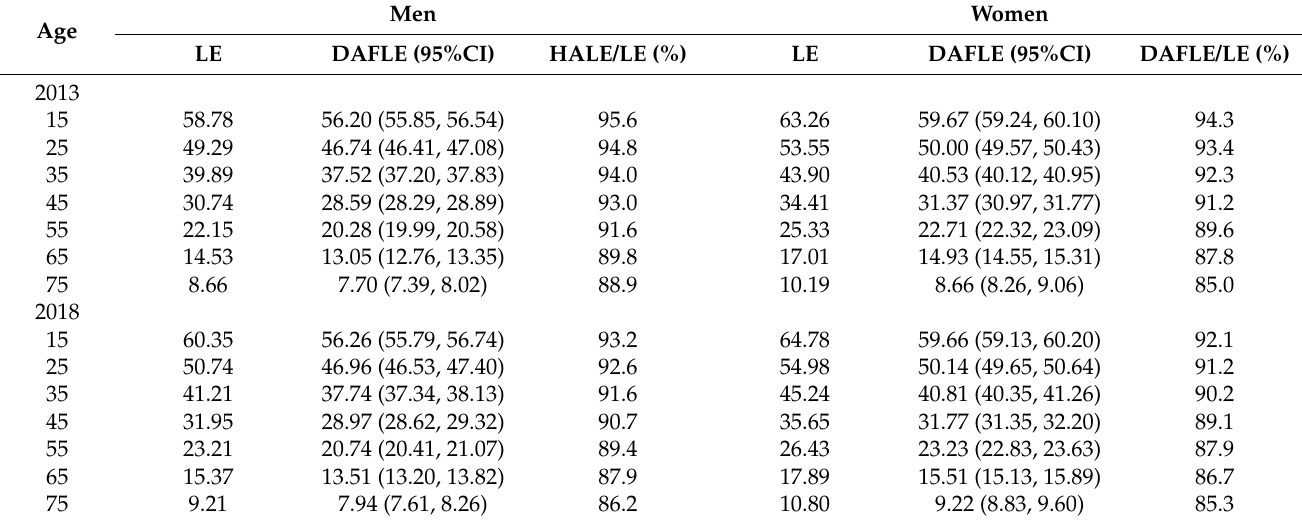
Table 1. LE, DAFLE and the proportion of DAFLE in Jiangxi, China, by sex and age for the years 2013 and 2018. Age